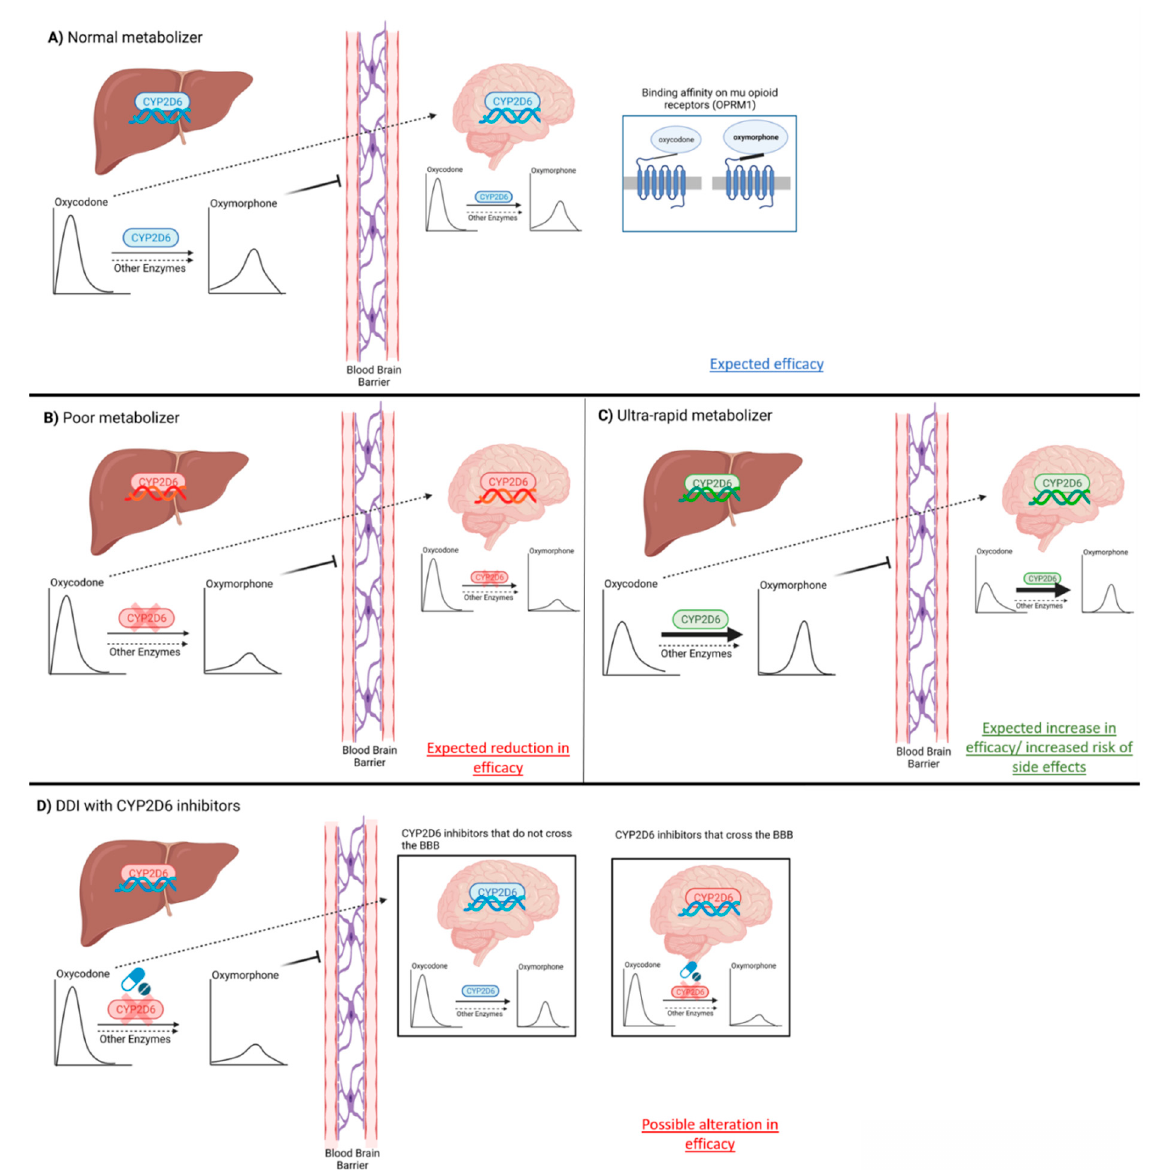
Figure 2. Implications of pharmacokinetics (including CYP2D6 genetic polymorphism and CYP2D6 drug–drug interactions) and pharmacodynamics as determinants of interindividual difference in drug response to oxycodone and oxymorphone. CYP2D6: cytochrome P450 2D6; DDI: drug–drug interaction; BBB: blood–brain barrier. Created with Biorender.com (access date: 10 May